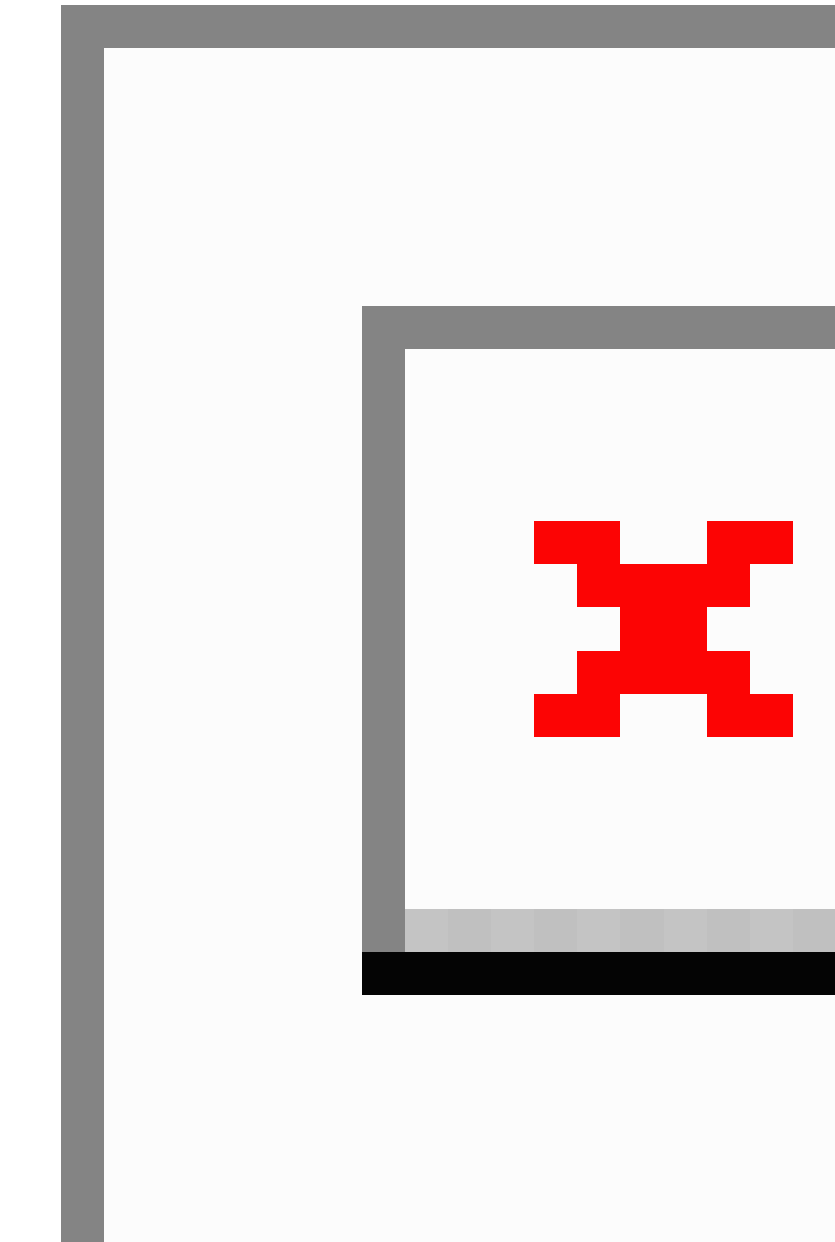
Figure 3. Final paper prototype design: (a) initial main screen; (b) new task input; (c) Stamina Credits assignment; (d) main screen with tasks;